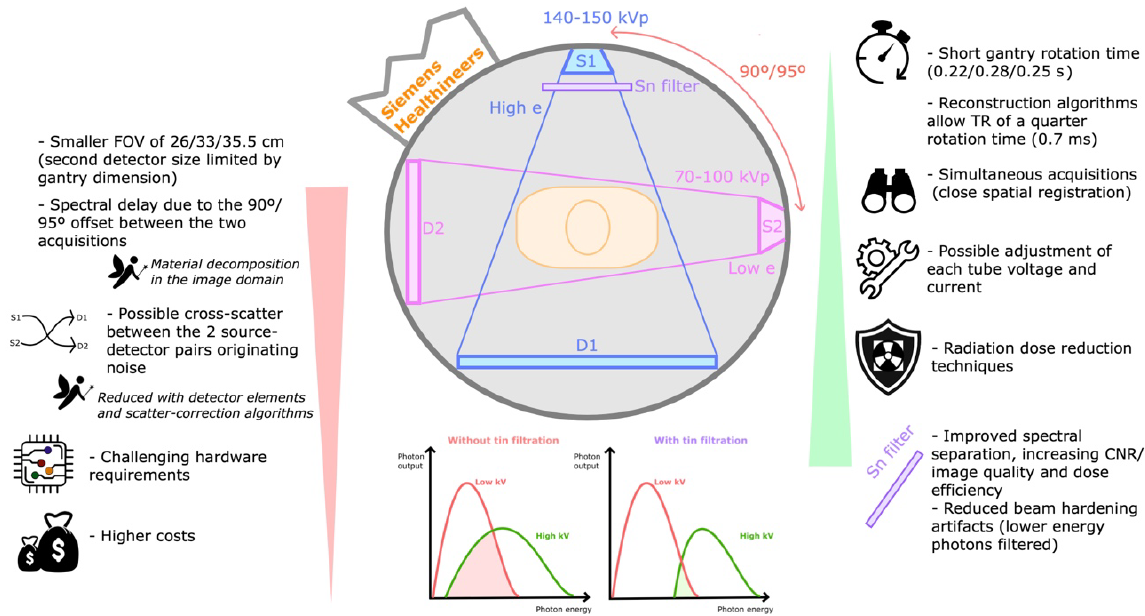
Figure 5. Dual-source DECT. Schematic representation of dual-source DECT scanner and its draw- backs (listed on the left) and strengths (listed on the right). These scanners (commercialized by Siemens Healthineers) are composed of two source-detector pairs dispersed almost perpendicularly. Simultaneous scans are obtained with high- and low-energy spectra (typically 80–100 kVp and 140–150 kVp). The added metallic tin (Sn) filter in the high-energy x-ray tube improves spectral separa- tion, increasing the dose efficiency and CNR (contrast-to-noise ratio), and reduces beam hardening